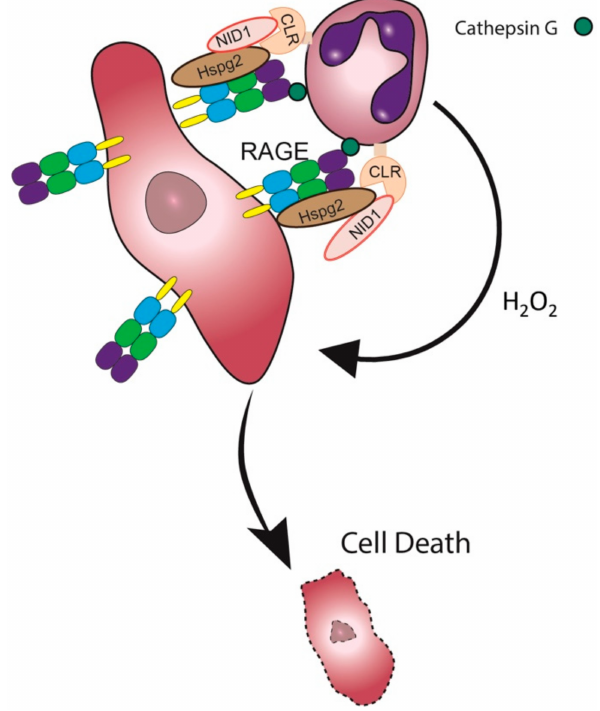
Figure 7. A proposed model of the neutrophil-tumor cell synapse. CLR – C-type Lectin Receptor; NID1 –